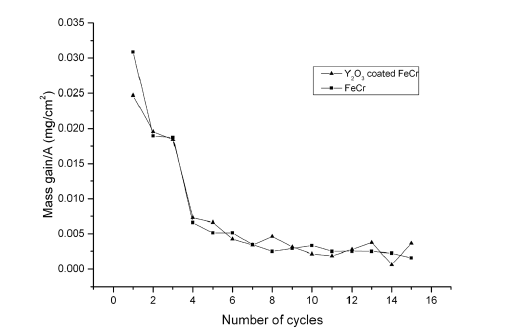
Figure 4: XRD spectrum of Y oxidized for 200 h at 1000 ºC.